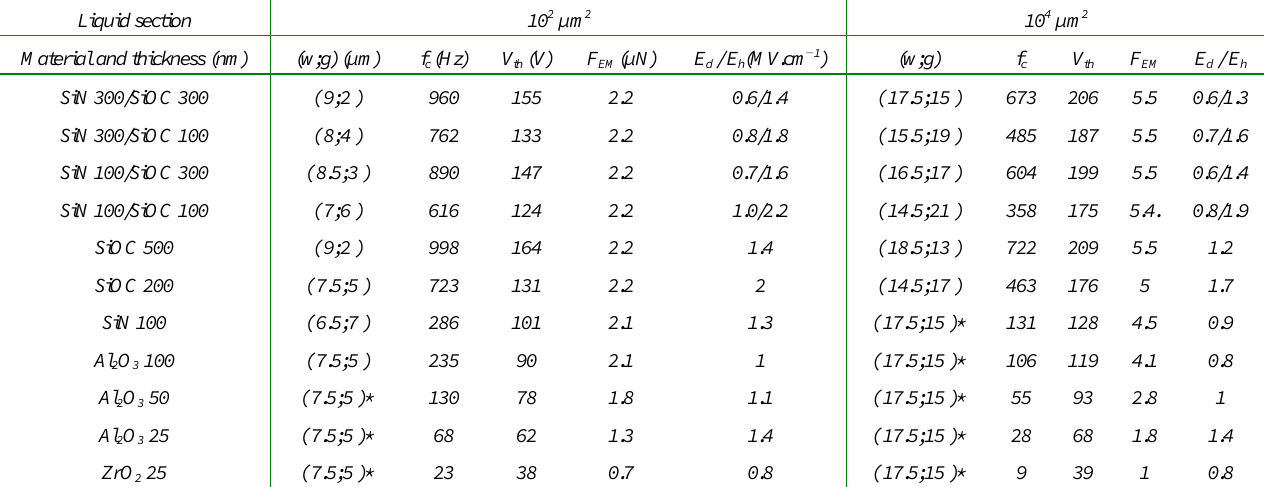
Table 3. Usual stacked materials and related LDEP parameters: electrode width w and inter-electrode gap g , the liquid semi-circular cross-section (radius w + 0.5 g ) The values ( w;g ) are directly chosen according to results presented in the Section 4.1. The * label refers to conditions for which the functions V = f(w) do not feature local minima: w and g th are arbitrary chosen. F is the electromechanical force in µN. E and E are the electric EM d h field (in MV cm −1 ) across the dielectric layer and the hydrophobic layer